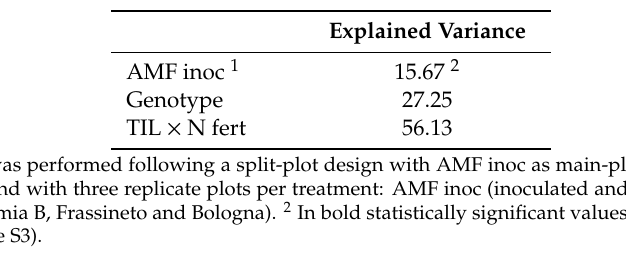
Table 1. Variation partitioning of the e ff ects of wheat genotype and AMF inoculation on AMF community composition and